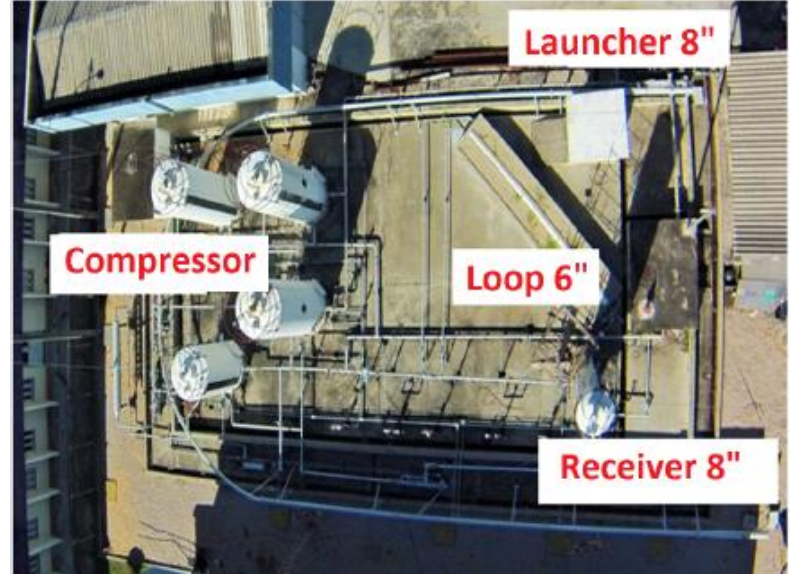
Figure 6. Testing Pipeline of 6” in Upper View. Source: Adapted from Lima et al.